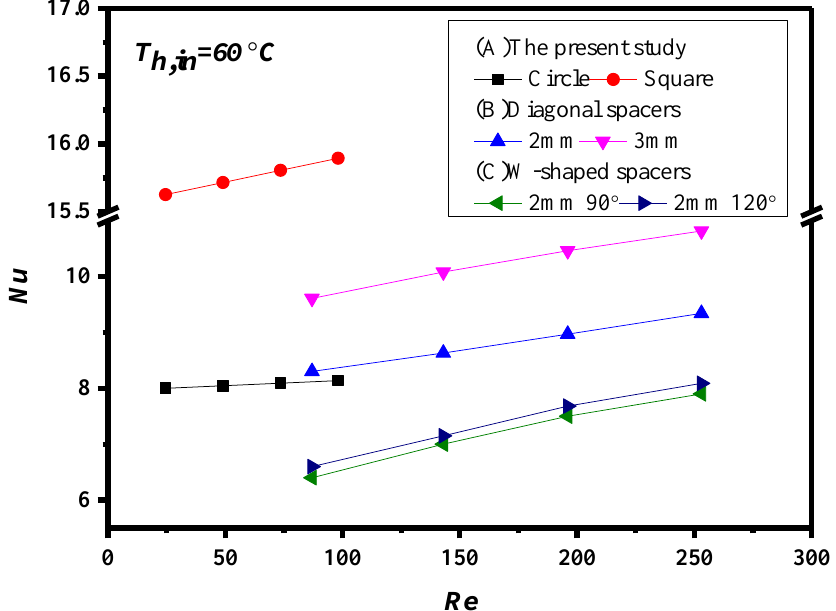
Figure 15. Comparisons of theoretical Nusselt numbers of the channels with inserting 3D turbulence promoters and two type of carbon-fiber spacers (countercurrent flow).